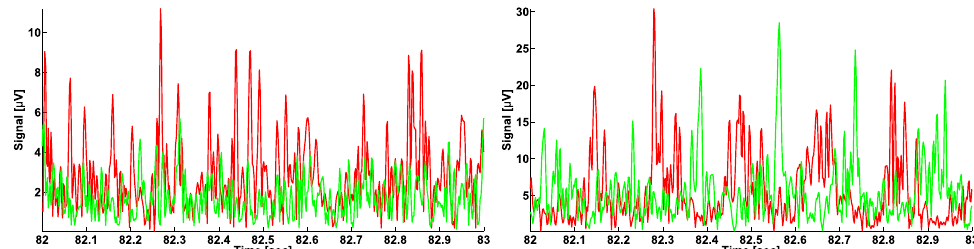
Figure 1. Patterns of tremor. Tremor signals are extracted from electromyographic (EMG) signals. The envelope of the EMG signals is used as the tremor signal; the Hilbert transform is used for computing the envelope of the signal. The signals from the flexor and extensor muscles are indicated in green and red, respectively. ( Left ), the synchronous pattern of tremor. ( Right ), the alternating pattern of tremor. The abscissa is time in seconds. The ordinate is the envelope of the signal in µ